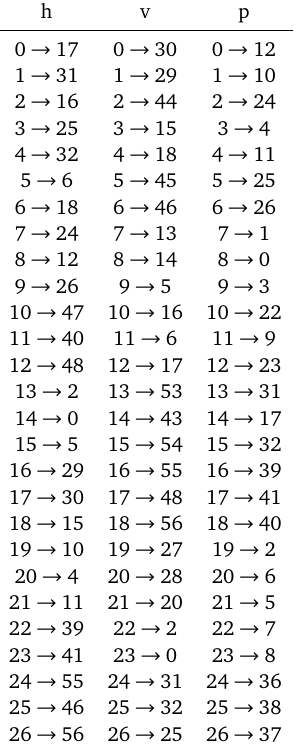
Permutations for the site indices that represent 90 ◦ rotations about the specified